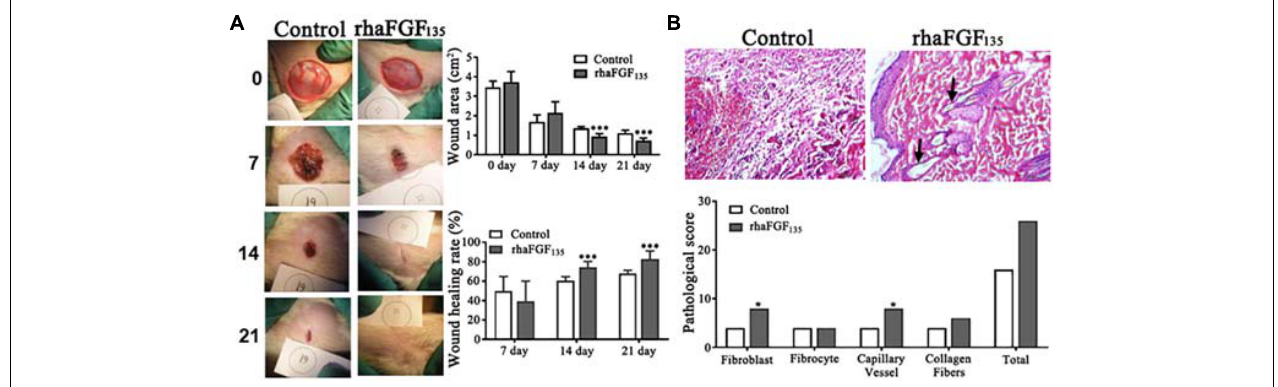
FIGURE 6 | The healing effect of rhaFGF 135 on full-thickness injury model in rats. (A) Photographs of skin wound and wound healing rates of STZ-induced SD rats with full-thickness wound. (B) Results of H&E staining (scale bar, 100 µ m) and its pathological score in full-thickness injury model in rats. Black arrows indicate regenerated hair follicle. Compared with the control group, * p < 0.05, *** p < 0.001, n = 7.